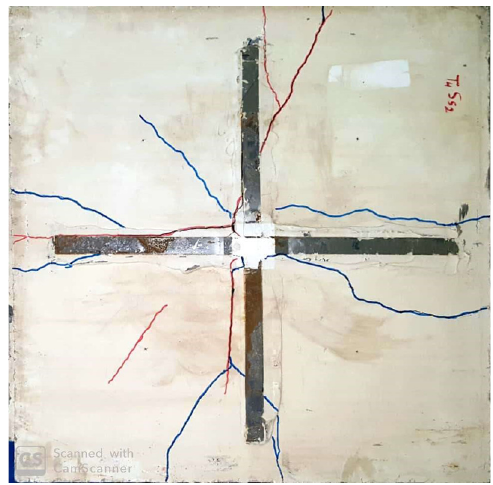
Figure 16: Crack pattern under impact - fl exural loads of the bottom face of the slab